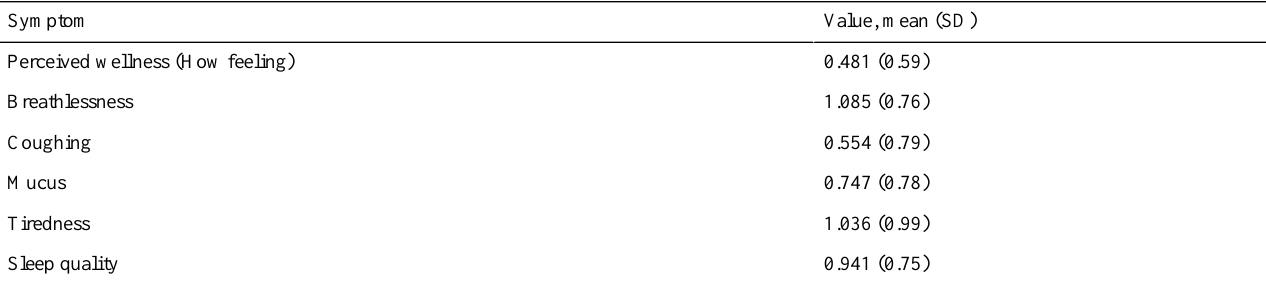
Table 2. Average rating for each symptom for all participants (N=37) over a 4-month period.